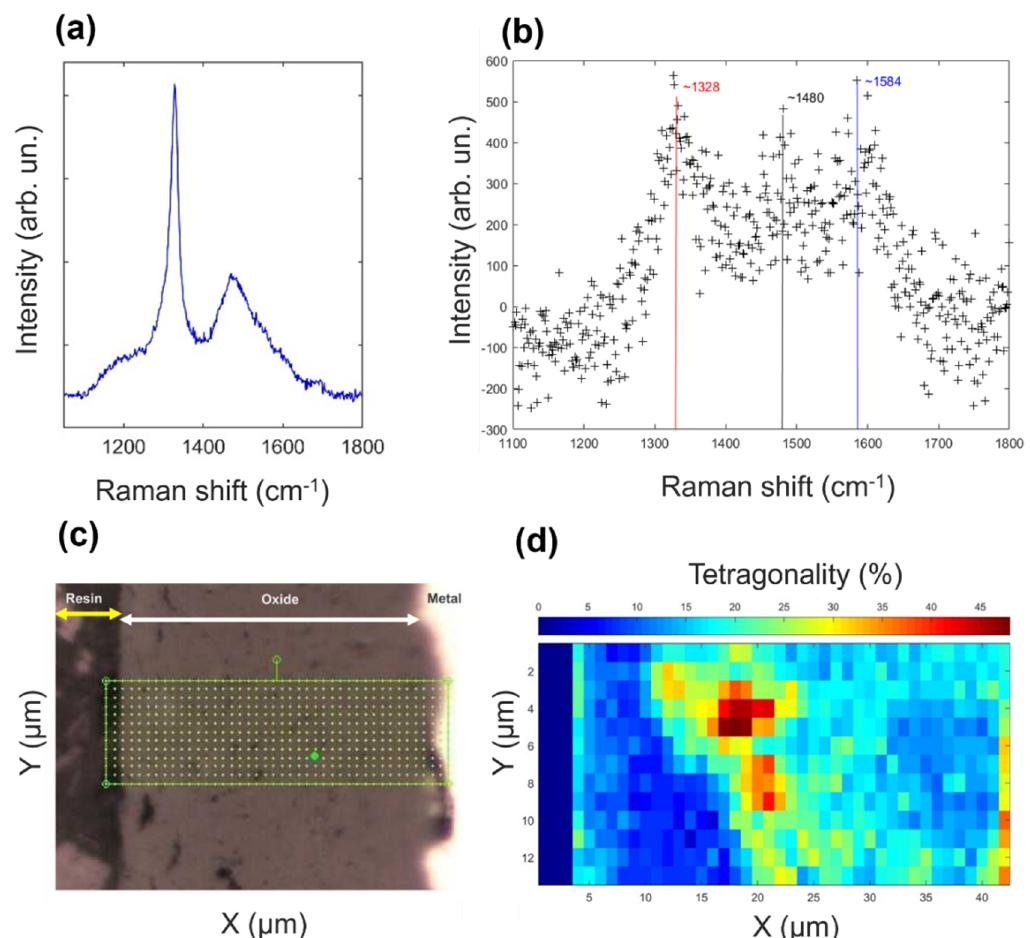
Figure 2. The as-prepared and high-temperature-treated ZIRLO rods characterized by non-destructive Raman spectroscopy. ( a , b ) Representative Raman spectra of the as-prepared carbon ZIRLO coating (coating contained less than 60% of diamond phase, spectra varied over the rod’s surface, see Figure S1 in Supplementary Material). ( b ) The diamond peak is seen at ~1328 cm − 1 accompanied by a G peak at ~1580 cm − 1 , and a peak at ~1480 cm − 1 , which we assigned to amorphous carbon. ( c ) Optical image of the mapped region and ( d ) a map of percent tetragonality for oxidized coated ZIRLO. The first three columns were set to zero as they represent or are strongly affected by the surrounding epoxy